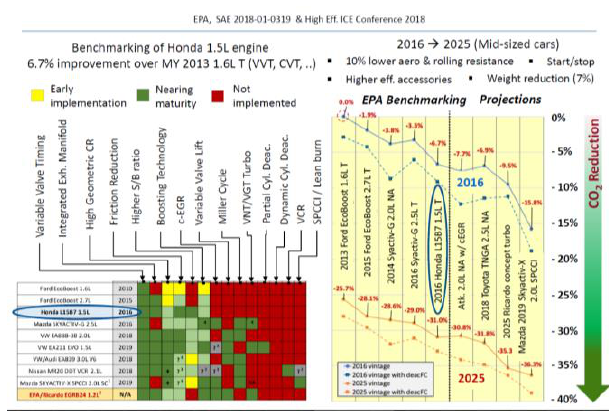
Fig. 2. Engine technology options for increased efficiency and reduced emissions [27]